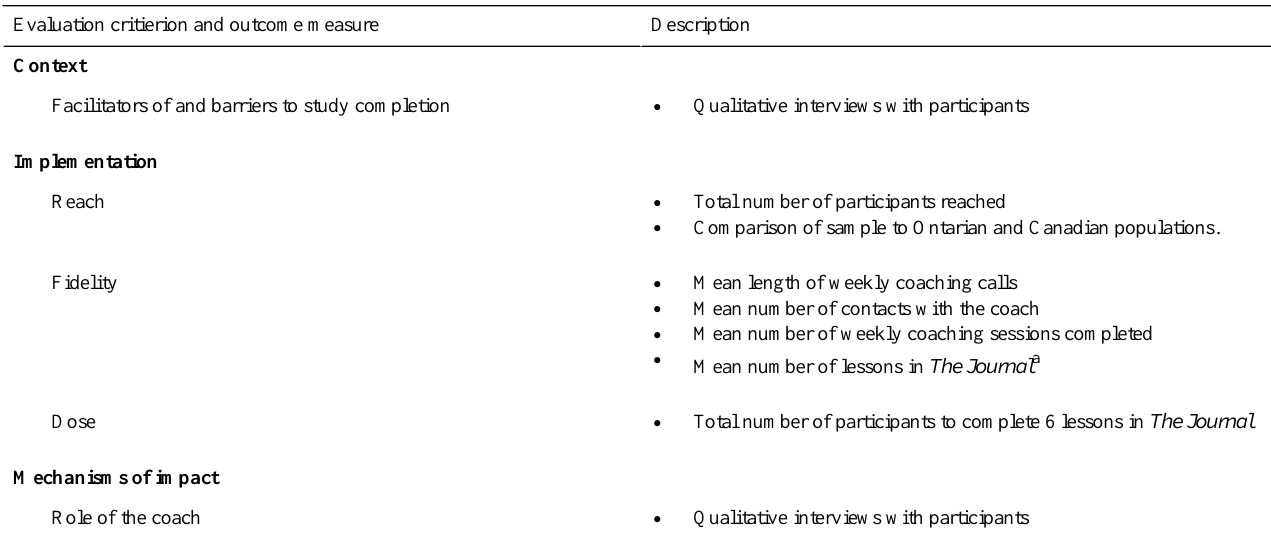
Table 3. Process evaluation outcome